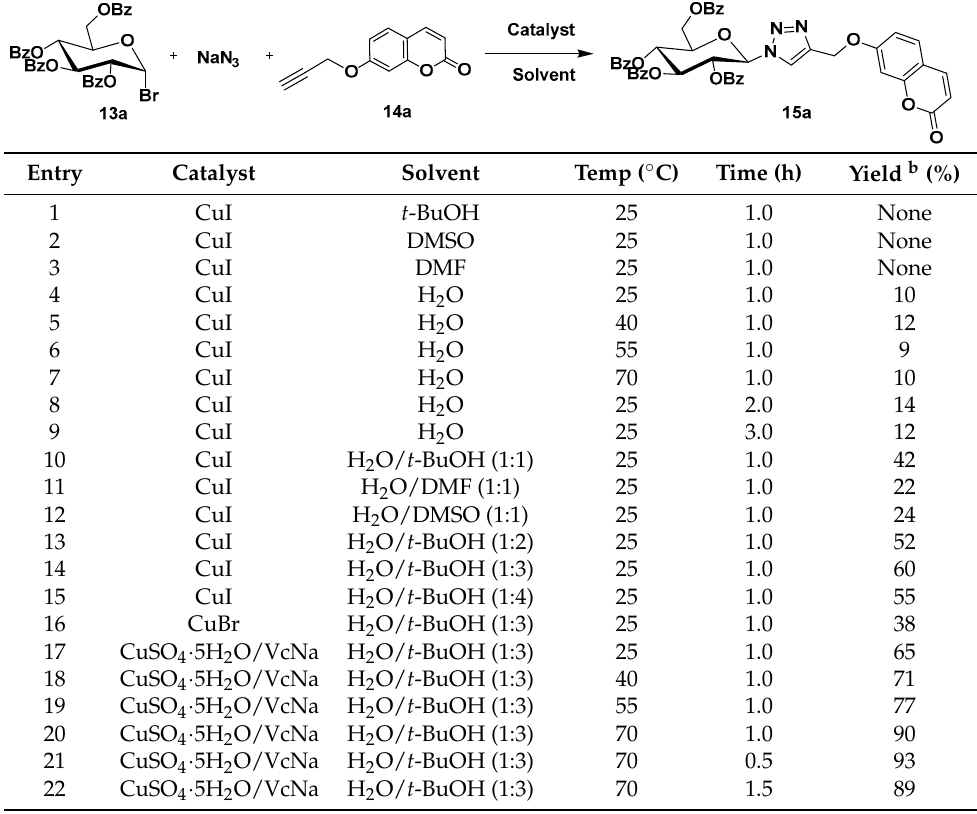
Table 1. One-Pot Synthesis of 15a from benzoyl glycosyl bromide, NaN 3 and alkyne a .